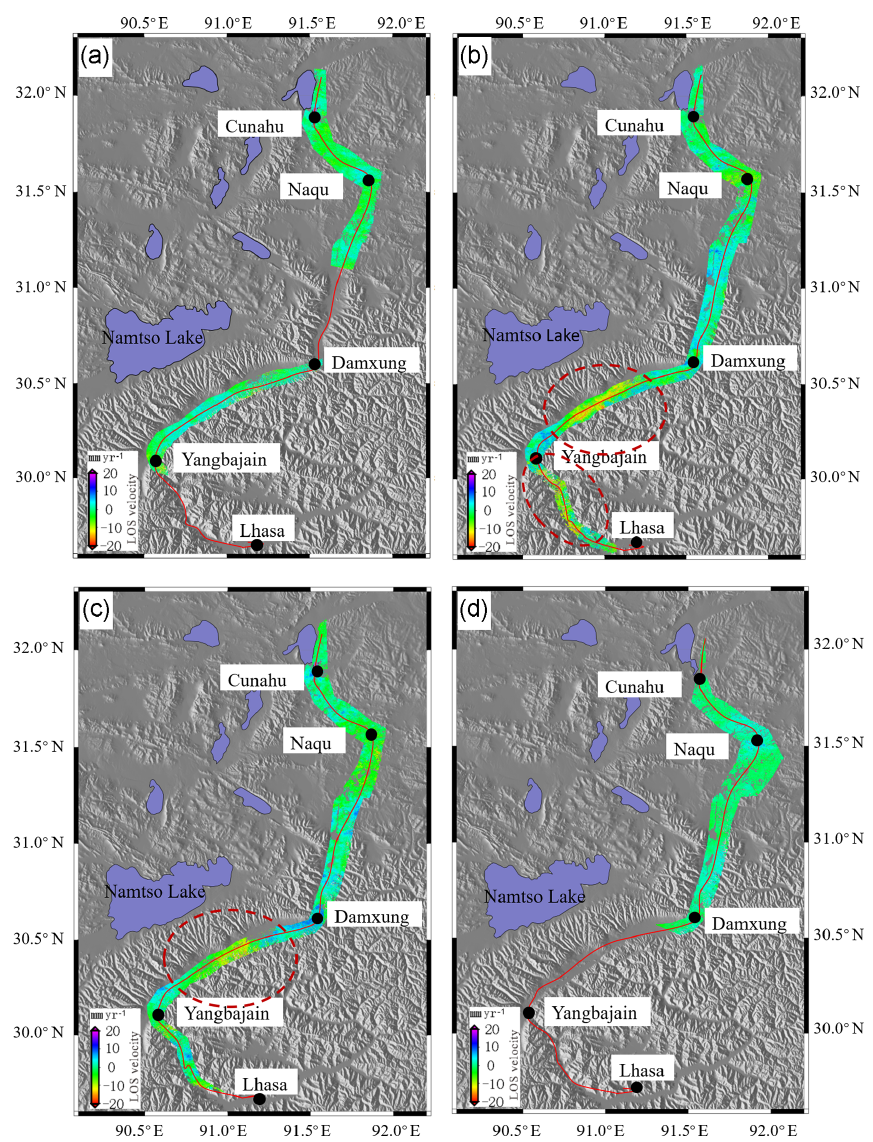
Figure 5. The InSAR results. Panel (a) represents the ASAR T405 results for the Lhasa–Naqu section of the Qinghai–Tibet Railway between 2003 and 2005. Panel (b) represents the ASAR T405 results for the Lhasa–Naqu section of the Qinghai–Tibet Railway in 2007, and the elliptical red dotted line represents the region of large deformation. Panel (c) represents the ASAR T405 data from 2008 to 2010. Panel (d) represents the ASAR T133 data from 2008 to 2010. The red line represents the railway. The black circle represents the main stations along the